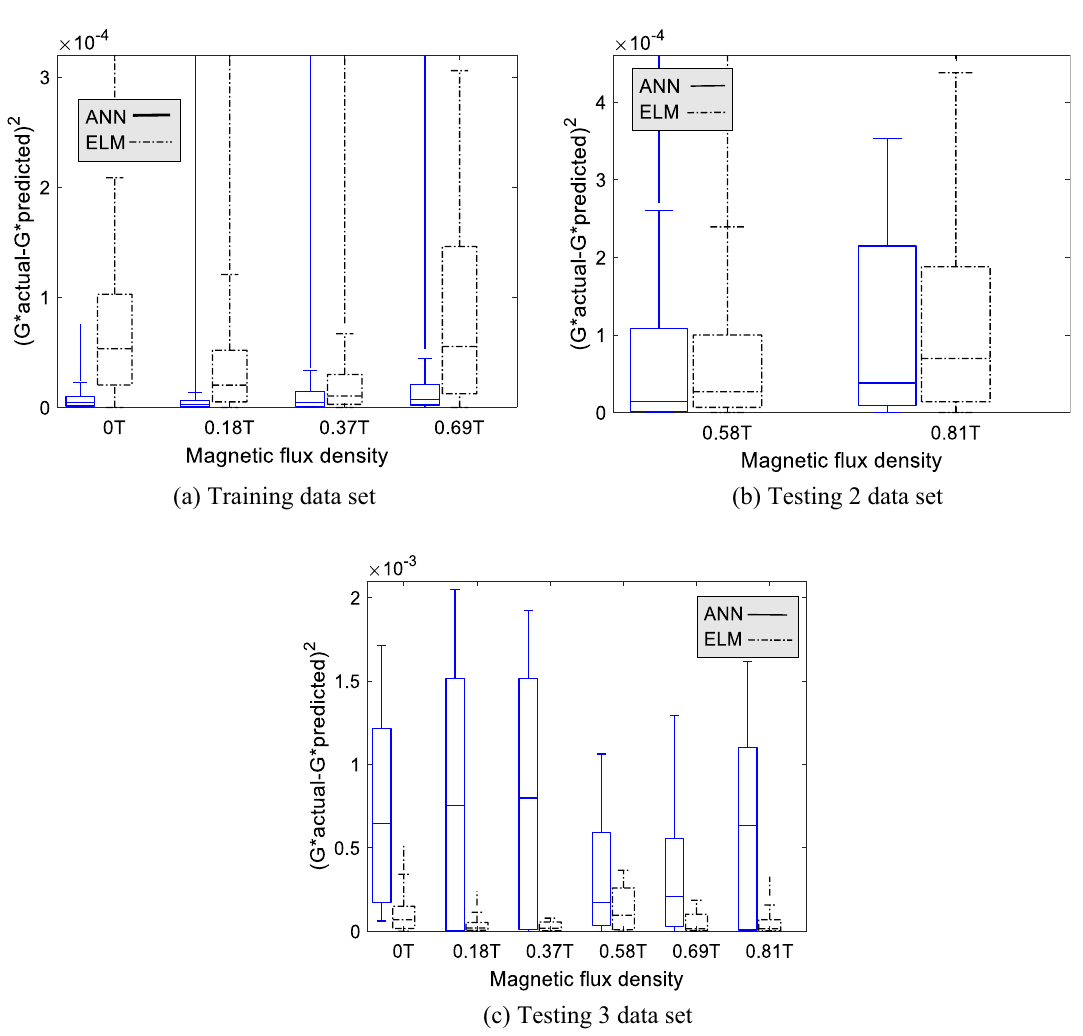
Figure 7. The boxplot of standard error for ANN and ELM model for three data set at particular magnetic flux